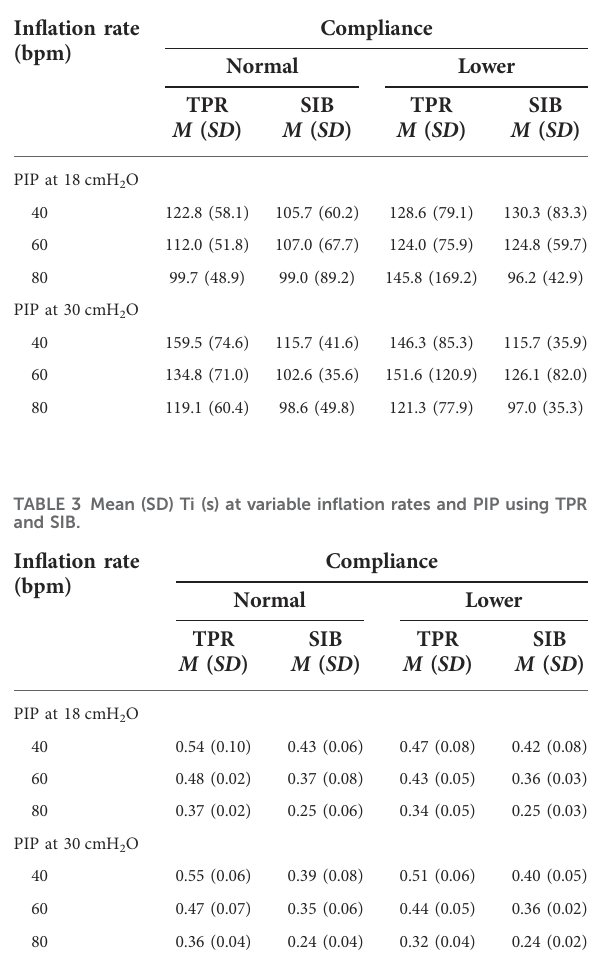
TABLE 2 Mean (SD) R rs (cmH 2 O/L/s) at variable in fl ation rates and PIP using TPR and SIB.